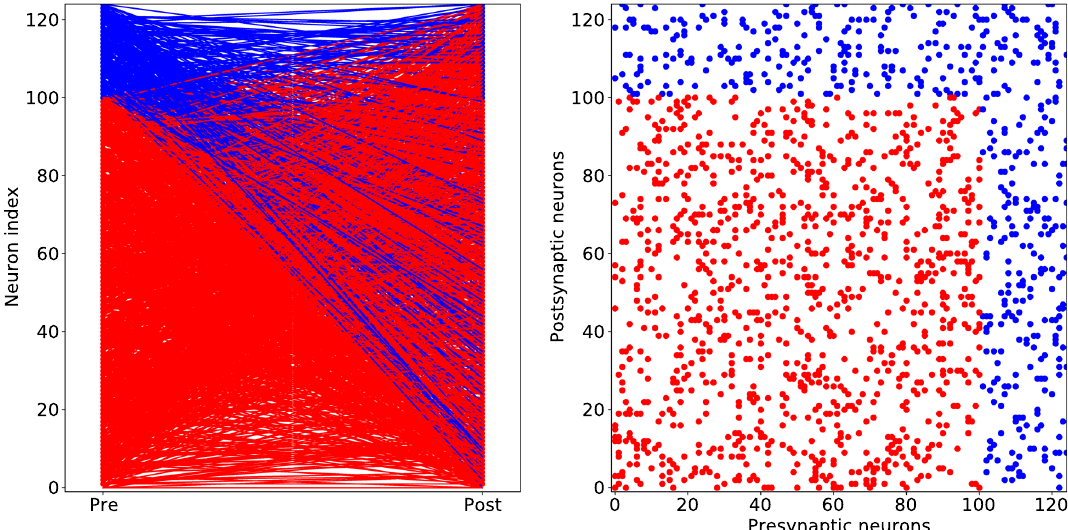
Figure 2. Scheme of synapse connections in neural networks. The left panel shows the connections between pre and postsynaptic neurons. Neurons on the vertical axis are ordered with excitatory ones, N ex , coming first followed by the inhibitory ones, N inh . The synaptic connections are illustrated by lines from the left (“Pre”) to the right (“Post”) in the figure. Red lines denote the excitatory connections, and the blue lines correspond to the inhibitory ones. The figure on the right shows connectivity matrix, w i , j , with coordinates according to the numbers of pre- and postsynaptic neurons. Each dot in the field denotes the presence of nonzero synaptic